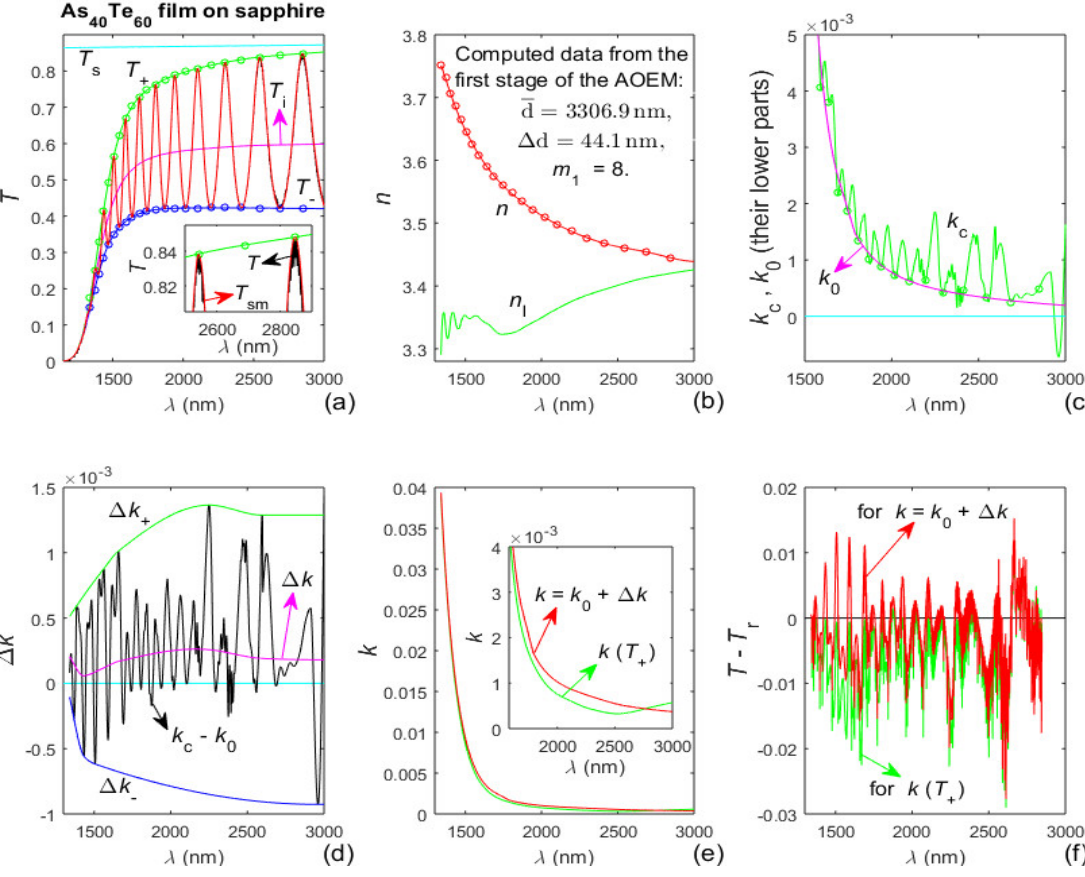
Figure 3. Input data and computed results from the characterization of the As 40 Te 60 film by the advanced optimizing envelope method (AOEM). ( a ) T s ( λ ), T ( λ ), T sm ( λ ), its envelopes T + ( λ ) and T − ( λ ), the points T + ( λ t ) and T − ( λ t ) represented by circles, and T i ( λ ); ( b ) n ( λ ) determined by optimized curve fitting over n 0 ( λ t ) visualized by circles, and its lower limit n l ( λ ); ( c ) k c ( λ ) obtained from Equation (1) and its optimized curve fitted k 0 ( λ ); ( d ) deriving the partially coherent light correction Δ k ( λ ) > 0; ( e ) k ( T + ) computed from Equation (2) and k = k 0 + Δ k ; ( f ) difference between T ( λ ) and T r ( λ ) computed using k ( T + ) and k = k 0 + Δ k , respectively.